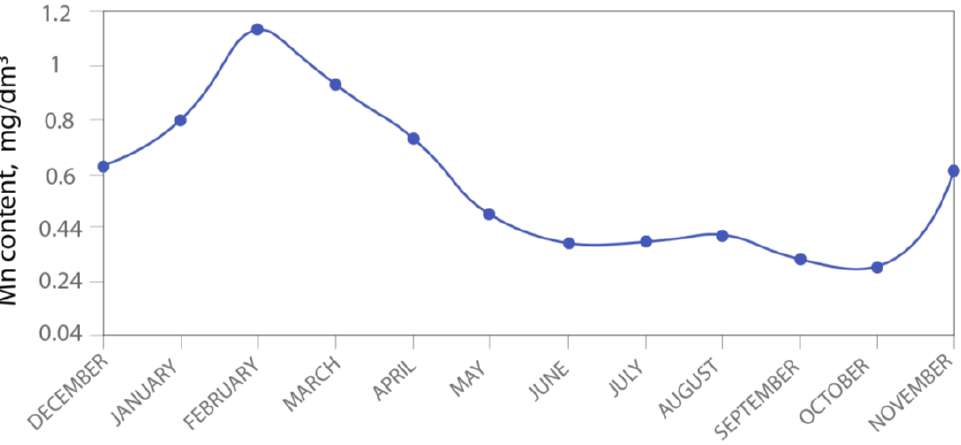
Figure 3. Seasonal dynamics of Mn content in the discharged wastewater of the processing plant. The data for the period from September to May are provided by the Environmental Department of the Kovdorsky GOK, and the measurements during the summer months are conducted by the authors.